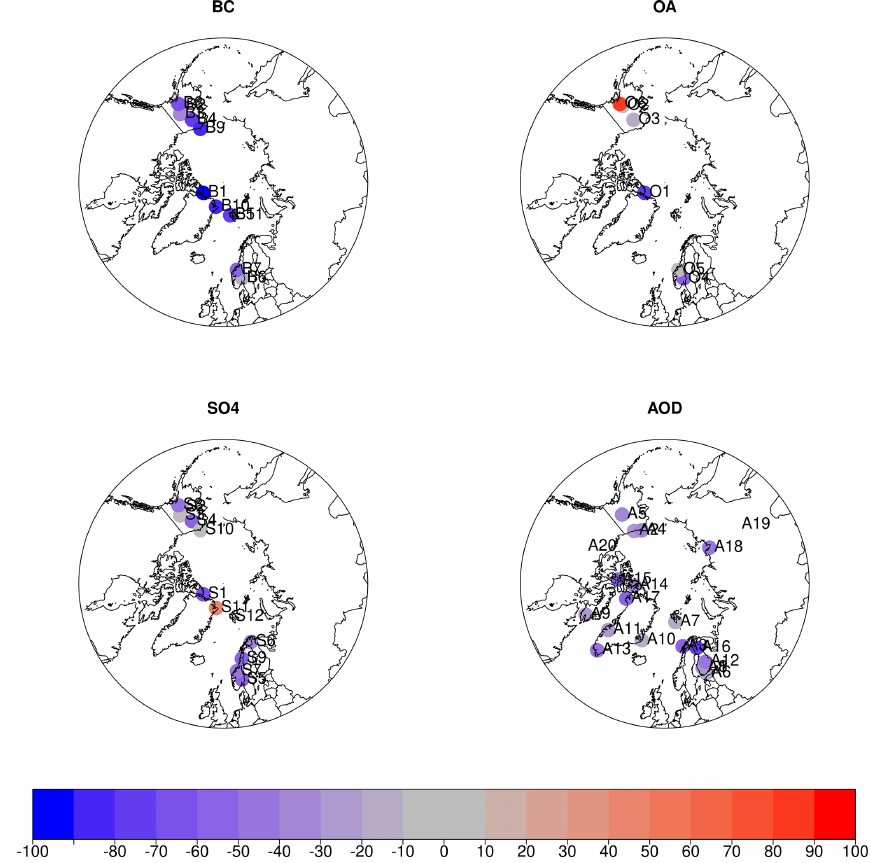
Figure 3. Spatial distribution of normalized mean bias (NMB, in %) for climatological mean (1995–2014) BC, OA, SO 2 − monitoring stations, calculated as the mean of all recent past